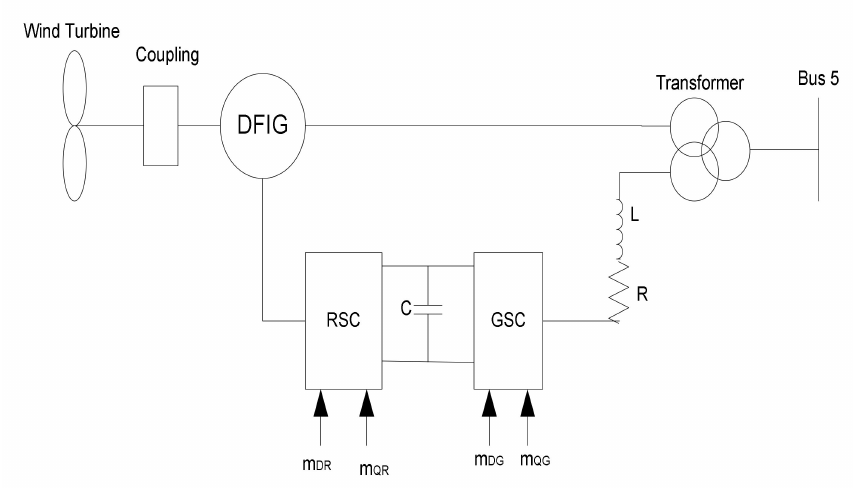
Figure 4. Doubly fed induction generator (DFIG)-based wind turbine